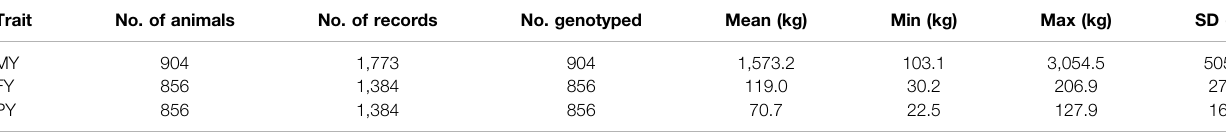
MY, milk yield; FY, fat yield; PY, protein yield.